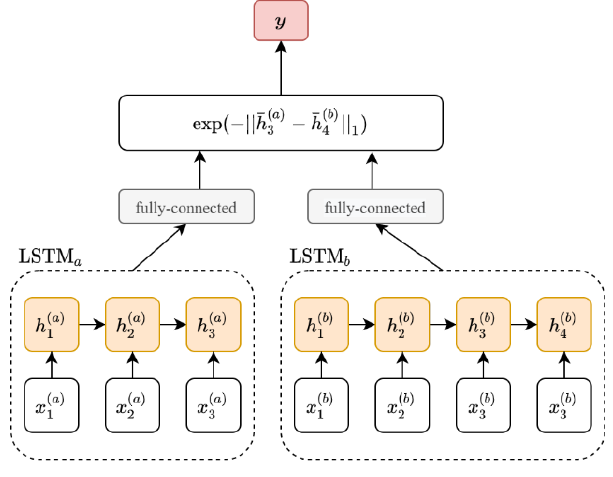
Fig. 4. MaLSTM with additional fully-connected layer